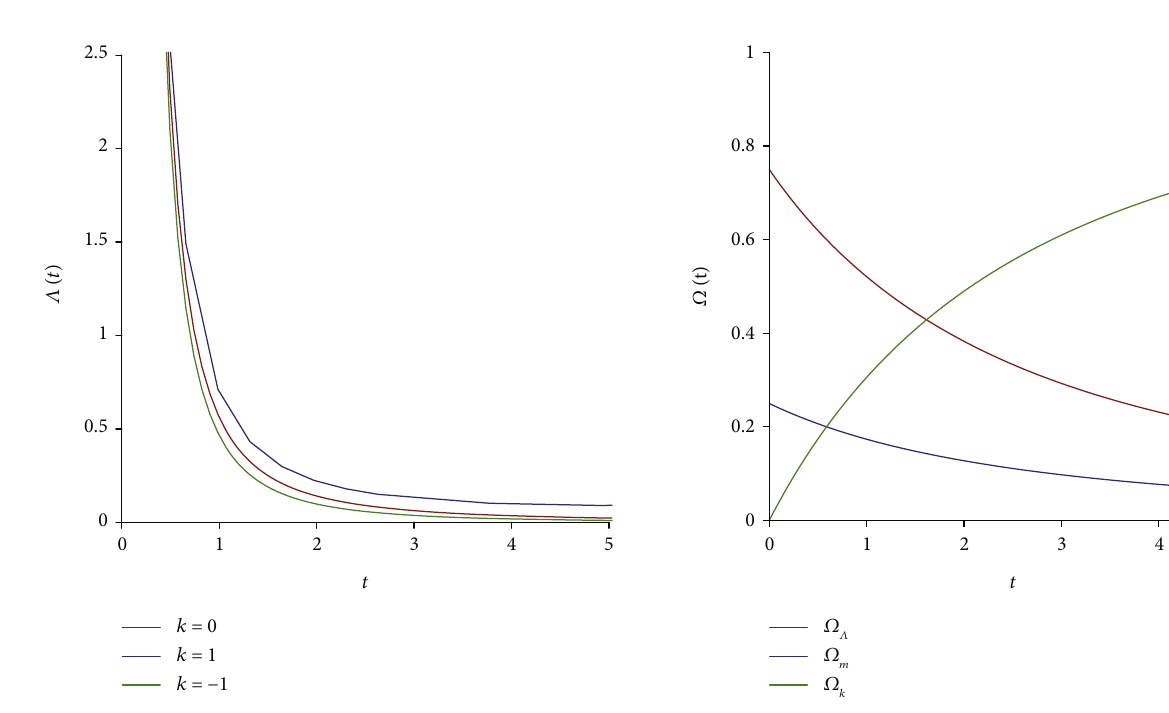
Figure 5: Plot of Λ ð t Þ versus t for di ff erent values of k . Figure